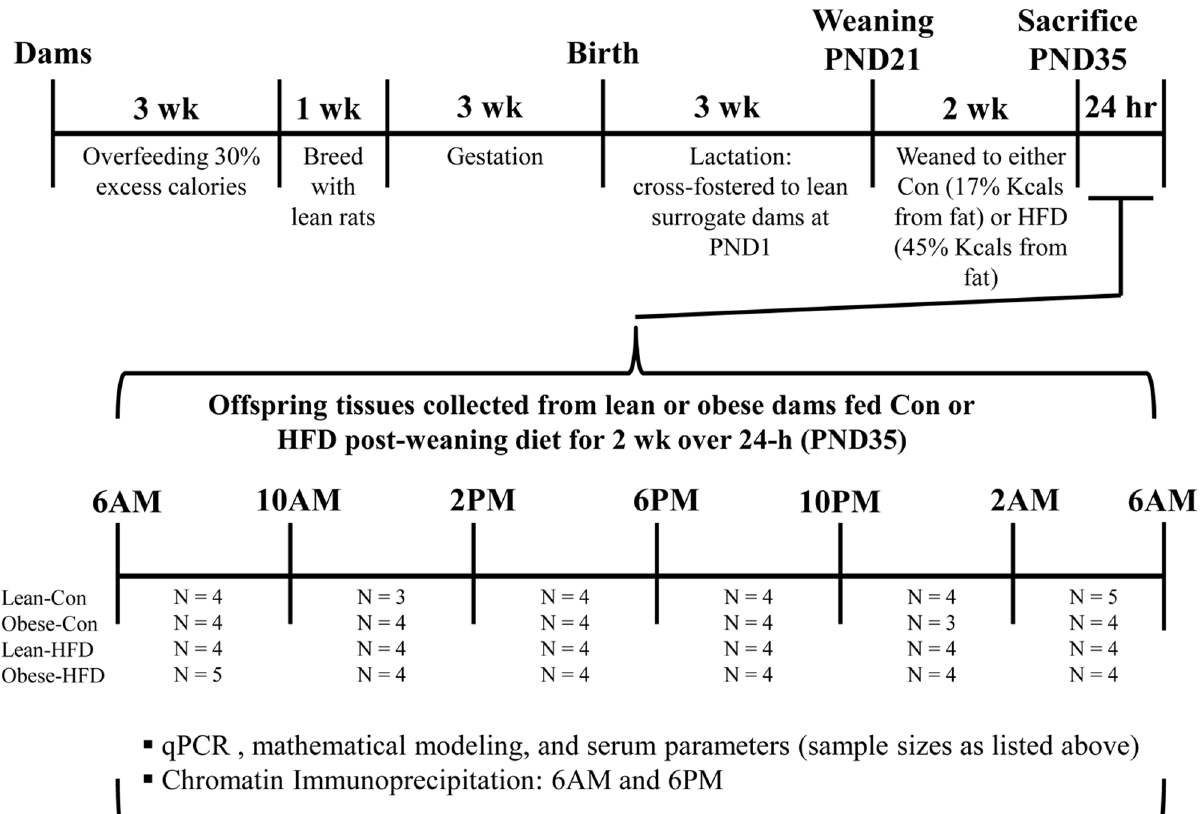
Figure 1. Schematic of experimental design, interventions and outcomes.